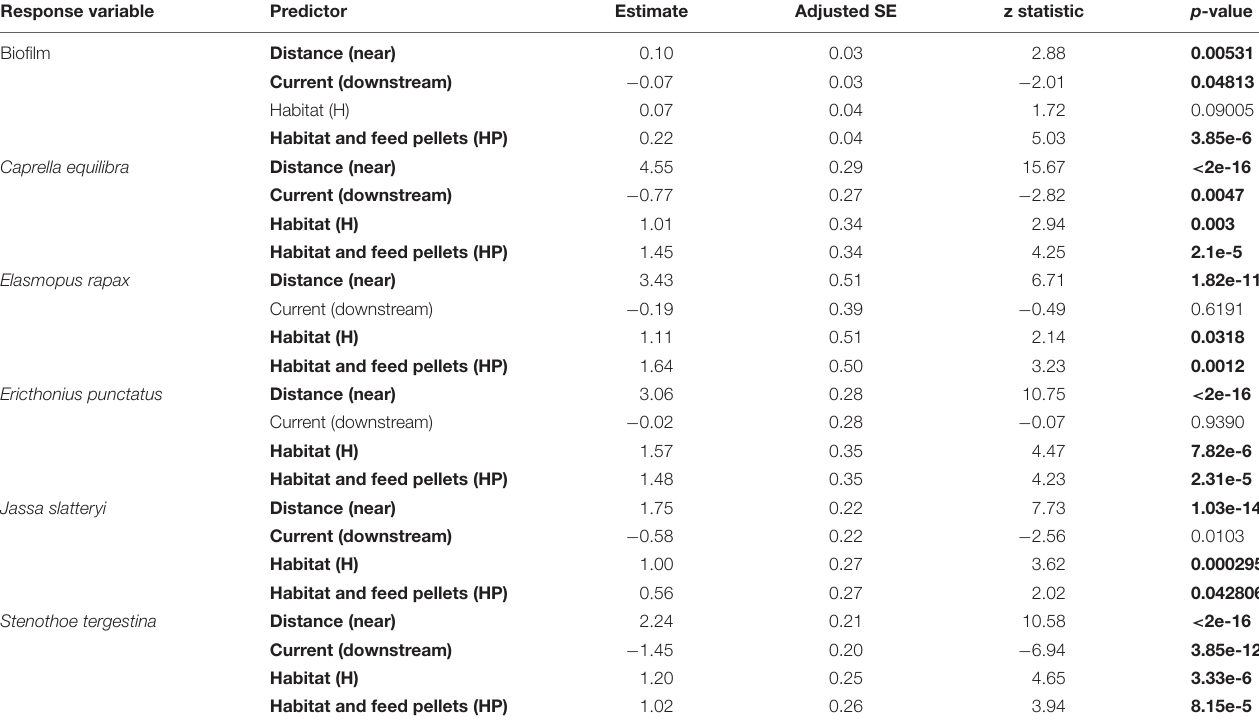
TABLE 1 | Results of the GLM testing for the effects of “Distance,” “Current,” and “Habitat suitability” for the biofilm and the most abundant amphipods of the assemblage, including associated P -values. Response variable Predictor Estimate Adjusted SE